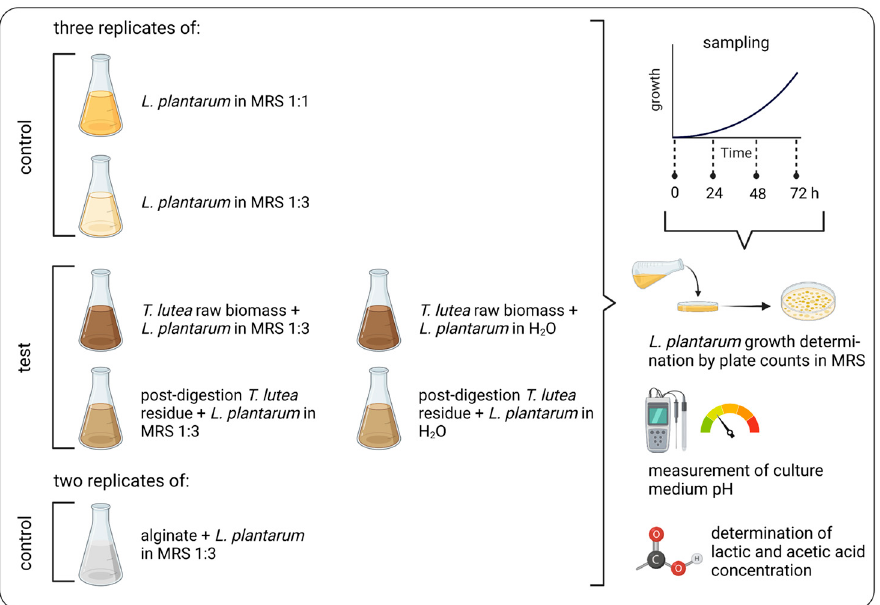
Figure 2. Outline of the fermentation trial of Tisochrysis lutea F&M-M36 raw biomass and post- digestion residue with Lactiplantibacillus plantarum ATCC 8014. Fermentation parameters followed during the trial are also reported.